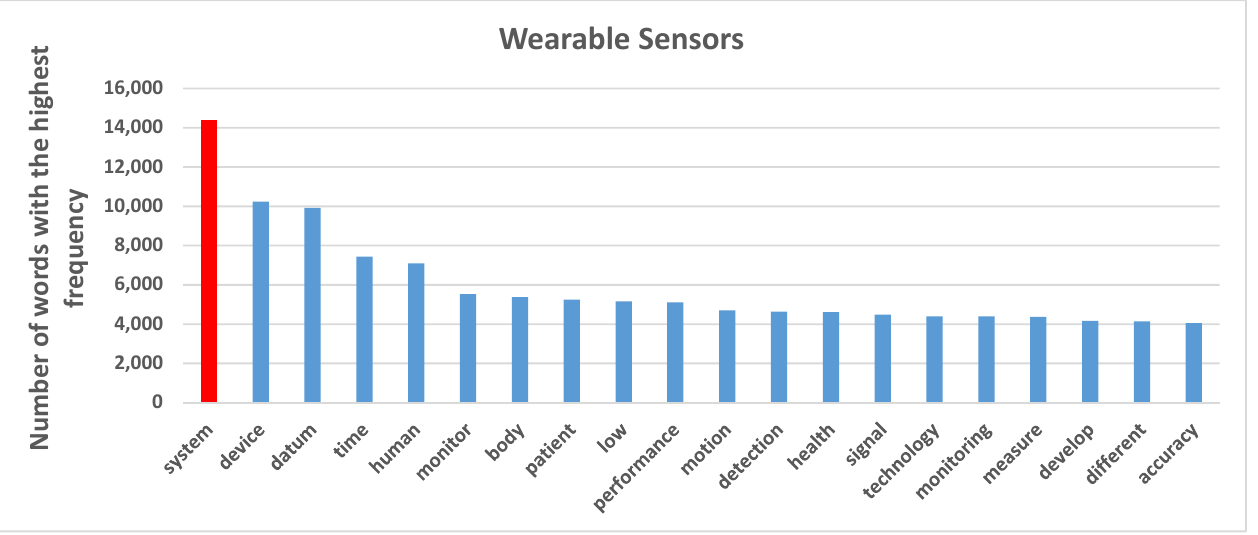
Figure 6. The highest frequent words in documents of wearable sensors.